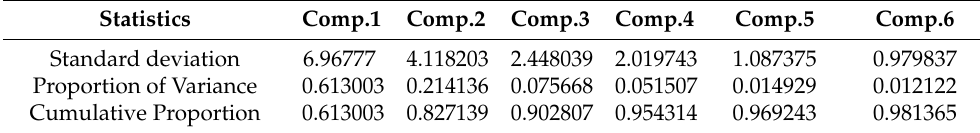
Figure 10. Projection of 80 VI values for Ambrosia artemisiifolia , Atriplex tatarica , Glycyrrhiza glabra , Euphorbia seguieriana , and Setaria pumila . Table 6. The value of the dispersion of the main components of the VIs Ambrosia artemisiifolia , Atriplex tatarica , Glycyrrhiza glabra , Euphorbia seguieriana , and Setaria pumila .